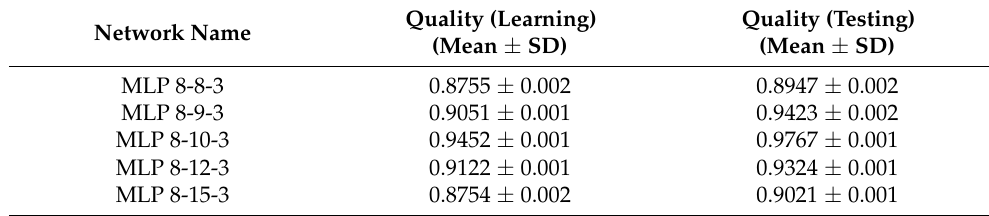
Table 3. Quality assessment of selected ANNs.